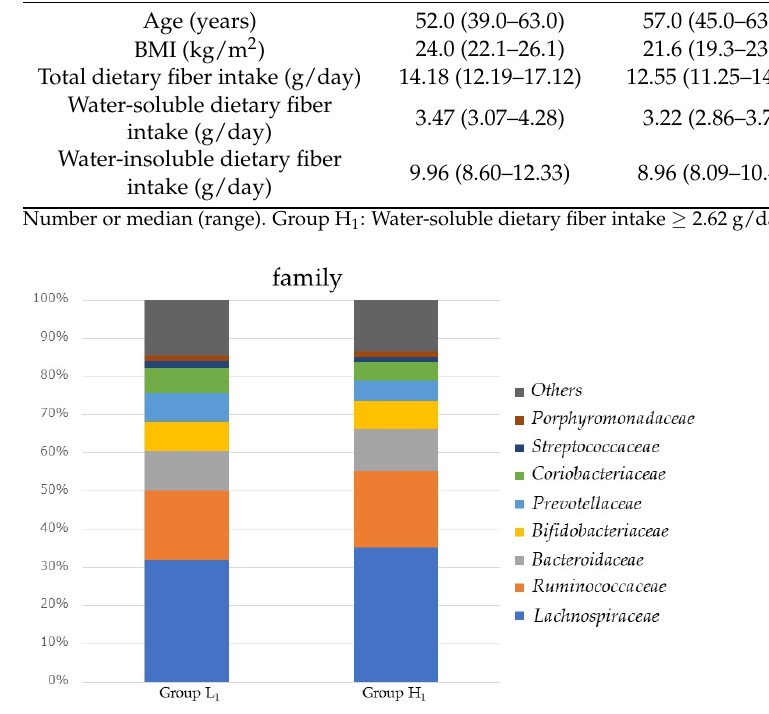
Figure 2. Comparison of the family relative abundance of gut microbiota in Group L 1 and H 1 . Group L 1 : Water-soluble dietary fiber intake < 2.62 g/day in 2017; Group H 1 : Water-soluble dietary fiber intake ≥ 2.62 g/day in 2017.